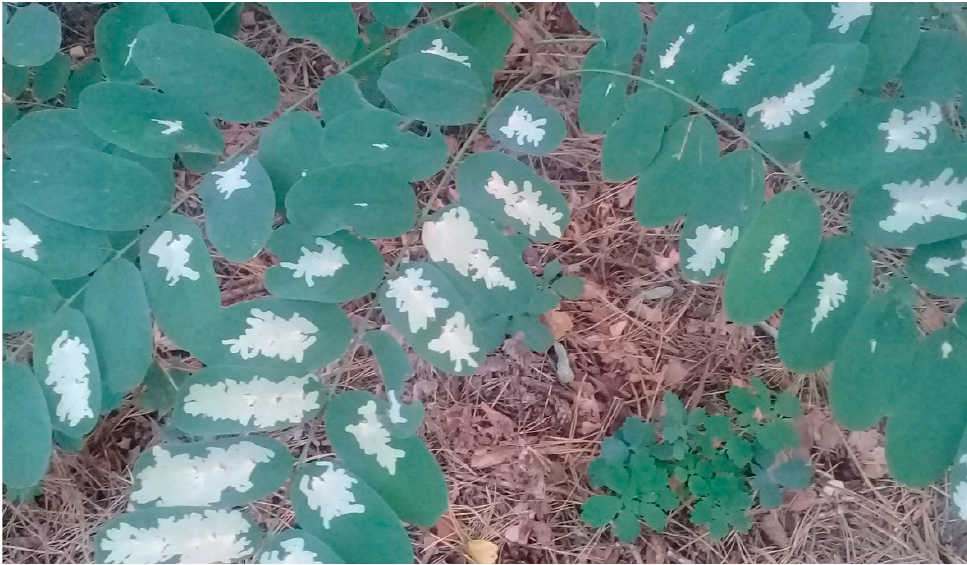
Figure 1. Locust digitate leafminer’s ( P. robiniella ) mines on black locust’s ( R. pseudoacacia ) leaves,